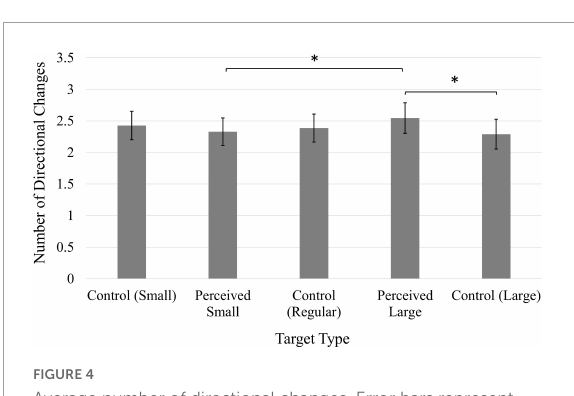
FIGURE4 Average number of directional changes. Error bars represent 95% confidence intervals. ∗ p <